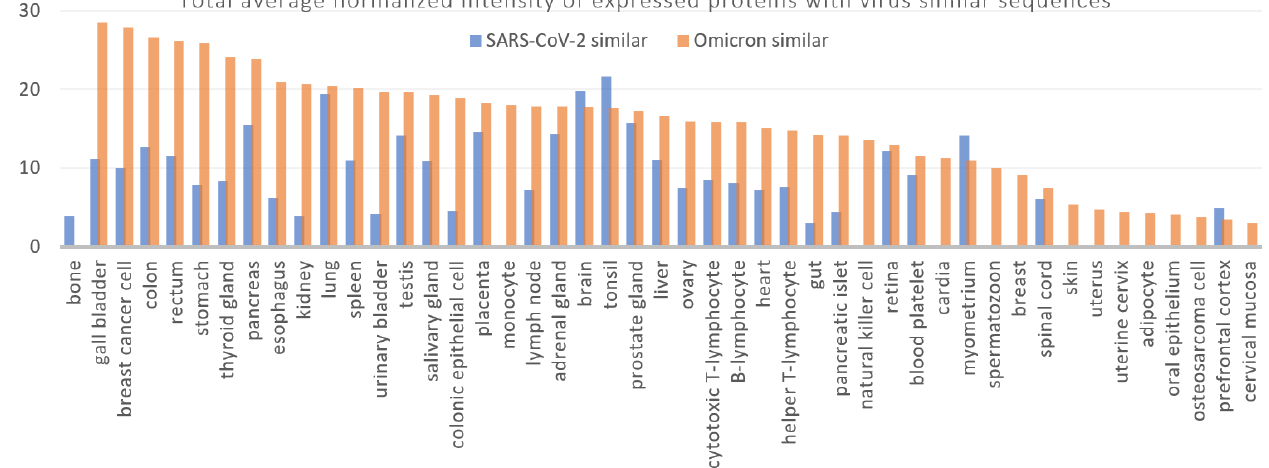
Figure 7. Total average normalized intensities of the identified human protein expression levels in the given tissues, in descending order of the total average normalized intensities of the expressed proteins with Omicron-similar peptides.